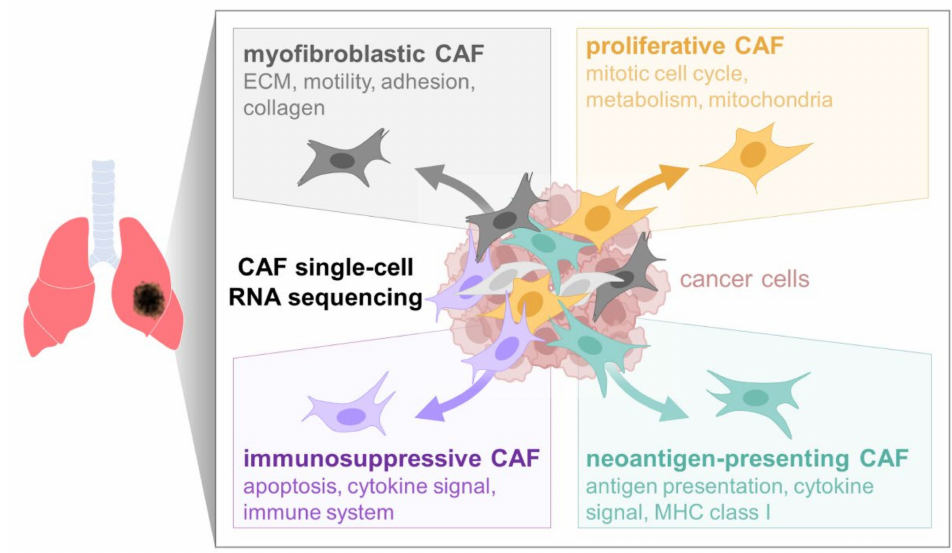
Figure 6. Subpopulations of lung CAFs identified in this study though